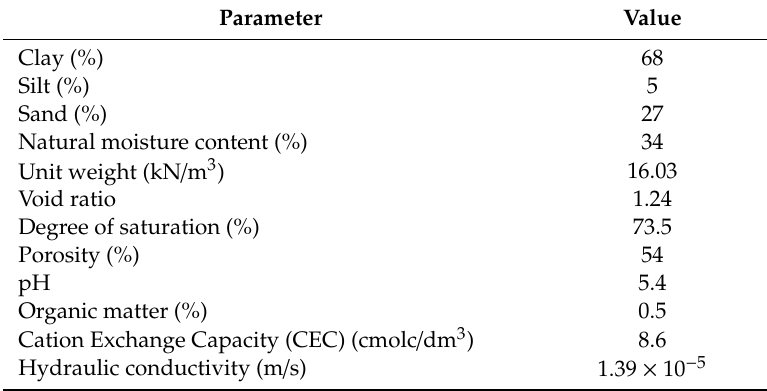
Table 1. Physical–chemical and geotechnical characteristics of the